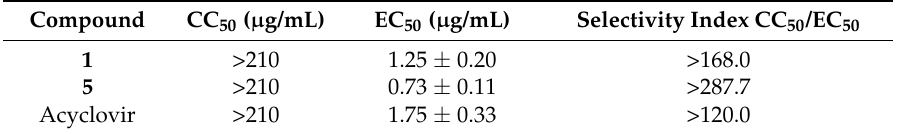
Table 2. Anti-HSV-2 activity and cytotoxicity of active compounds 1 and 5 .